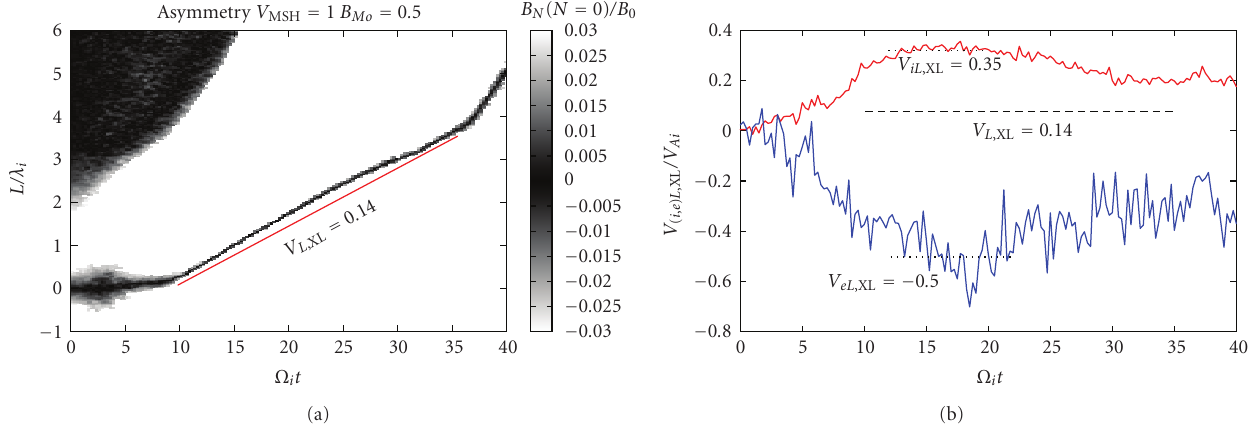
Figure 15: The results from the ( V MSH , B Mo ) = (1, 0 . 5) case, where the guide field and the velocity shear are considered to counteract in determining the direction of the X-line motion (See Table 1). The X-line motion shown in Panel (a) indicates that the shear flow e ff ects dominate. Discussion on the X-line properties shown in Panel (b) given in the text, however, suggests that there are some roles played by the electrons as well.